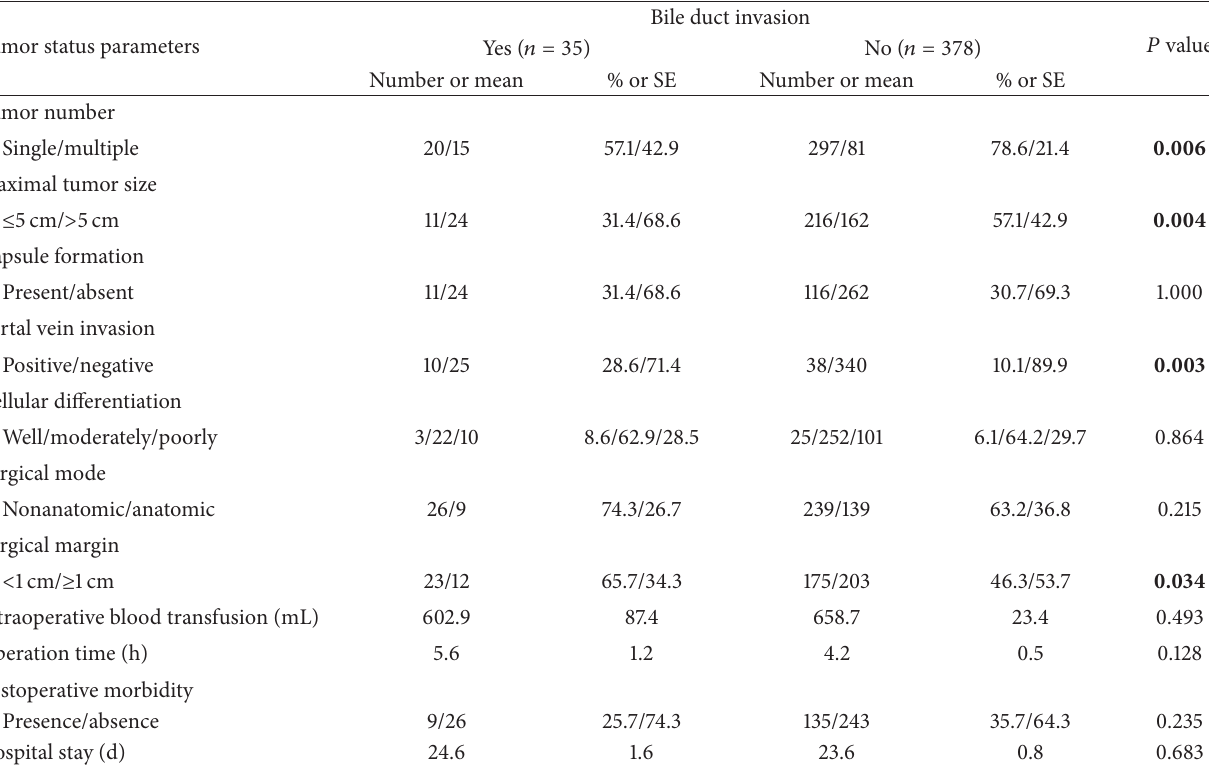
Table 2: Pathological and surgical parameters of HCC patients with and without bile duct invasion. Tumor status